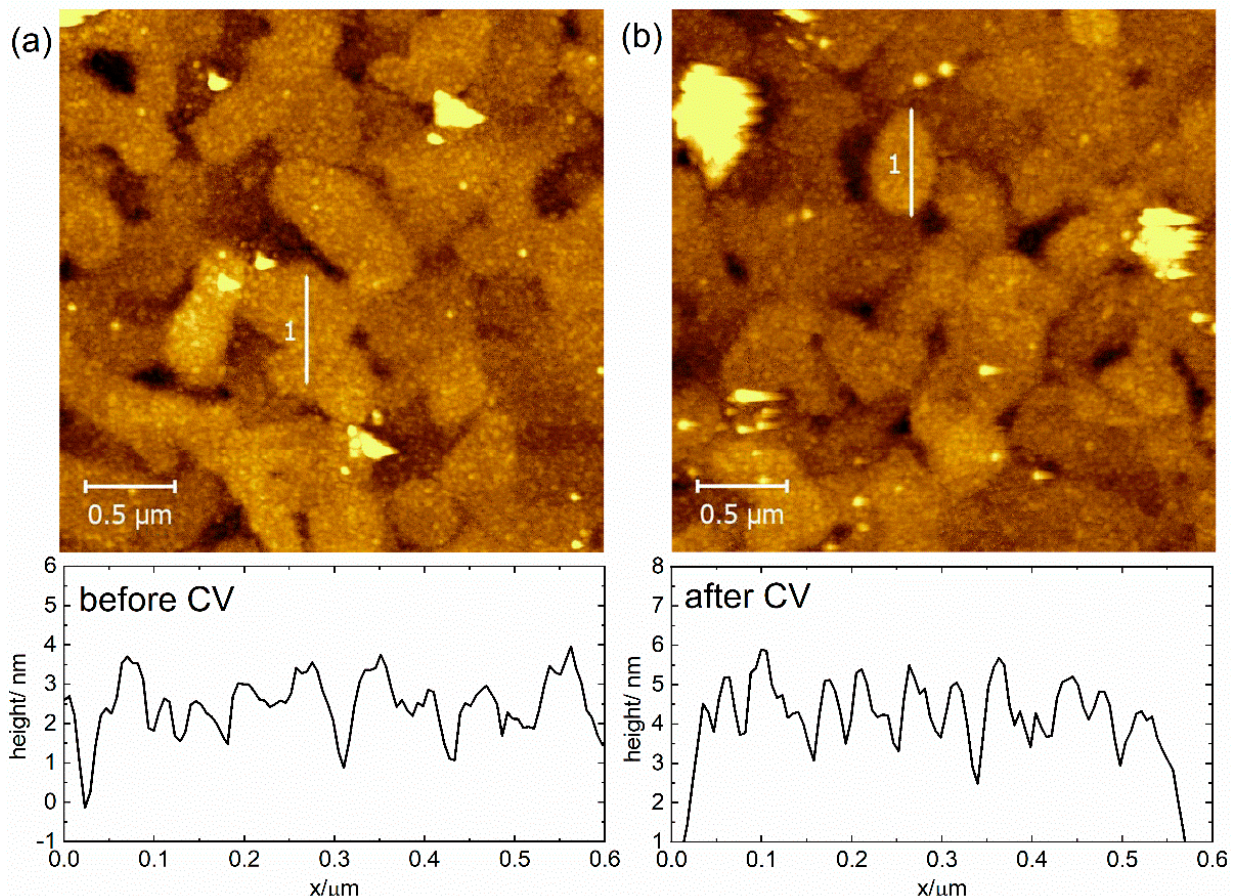
Figure 5. AFM topography image 3 × 3 μ m 2 and graph of height profile along line 1 (upwards) for Ru-tripod SAM on Au(111): ( a ) before; ( b ) after cyclic voltammetry experiment in 0.1 M TBAPF 6 in acetonitrile at scan rate 0.1 V s − 1 .